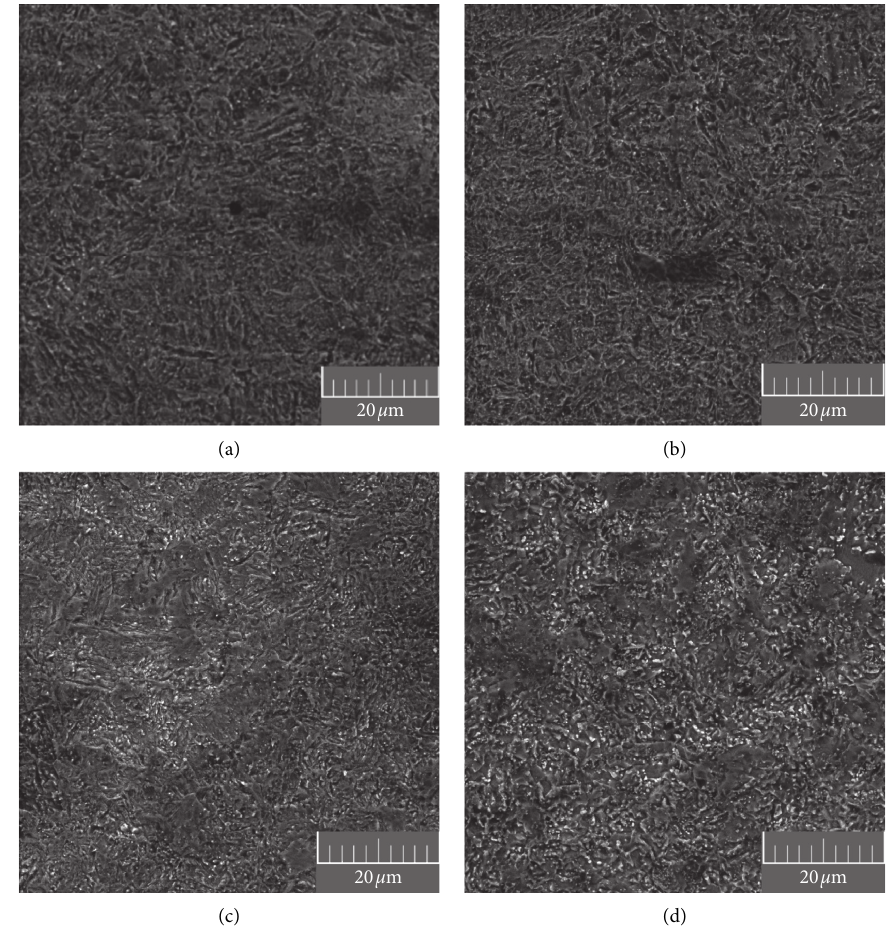
Figure 10: SEM micrographs of (a) CHTspecimen and CTspecimens treated at (b) − 120 ° C (CT3), (c) − 160 ° C (CT6), and (d) − 196 ° C (CT9) for